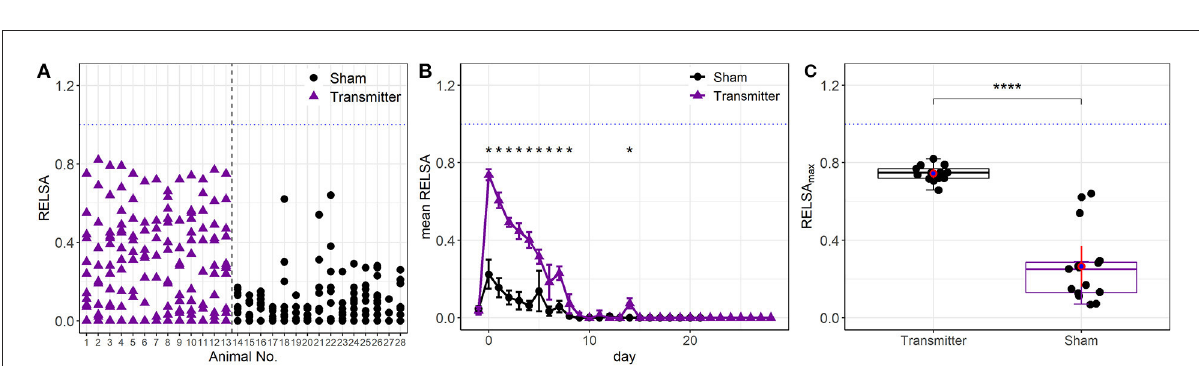
FIGURE5 (A) Single animal analysis with the full RELSA model (bwc, burON, hr, hrv, act, and temp). The average RELSA score was higher in the TM group than in the Sham group (average RELSA max,TM = 0.75 vs. average RELSA max,Sham = 0.26). In addition, at least three animals in the Sham